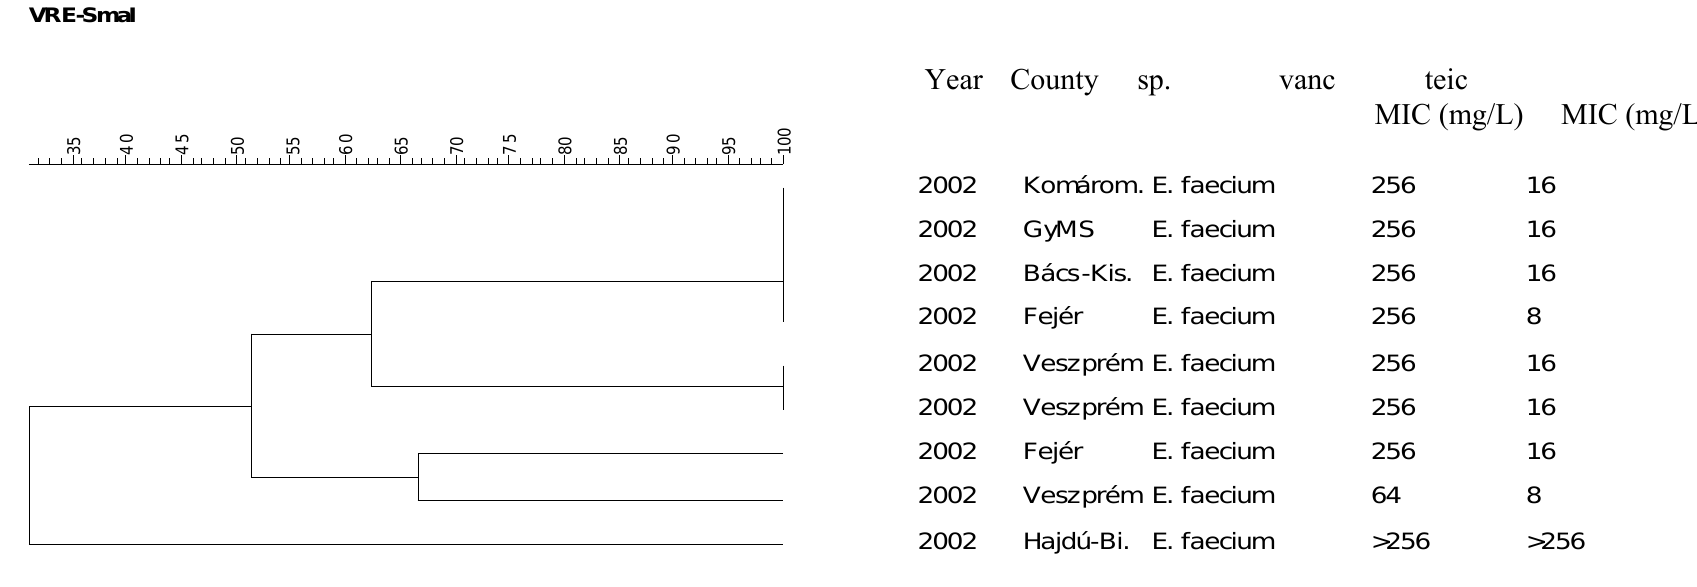
Figure 17. Dendrogram of vancomycin-resistant E. faecium strains isolated from chicken in 2002